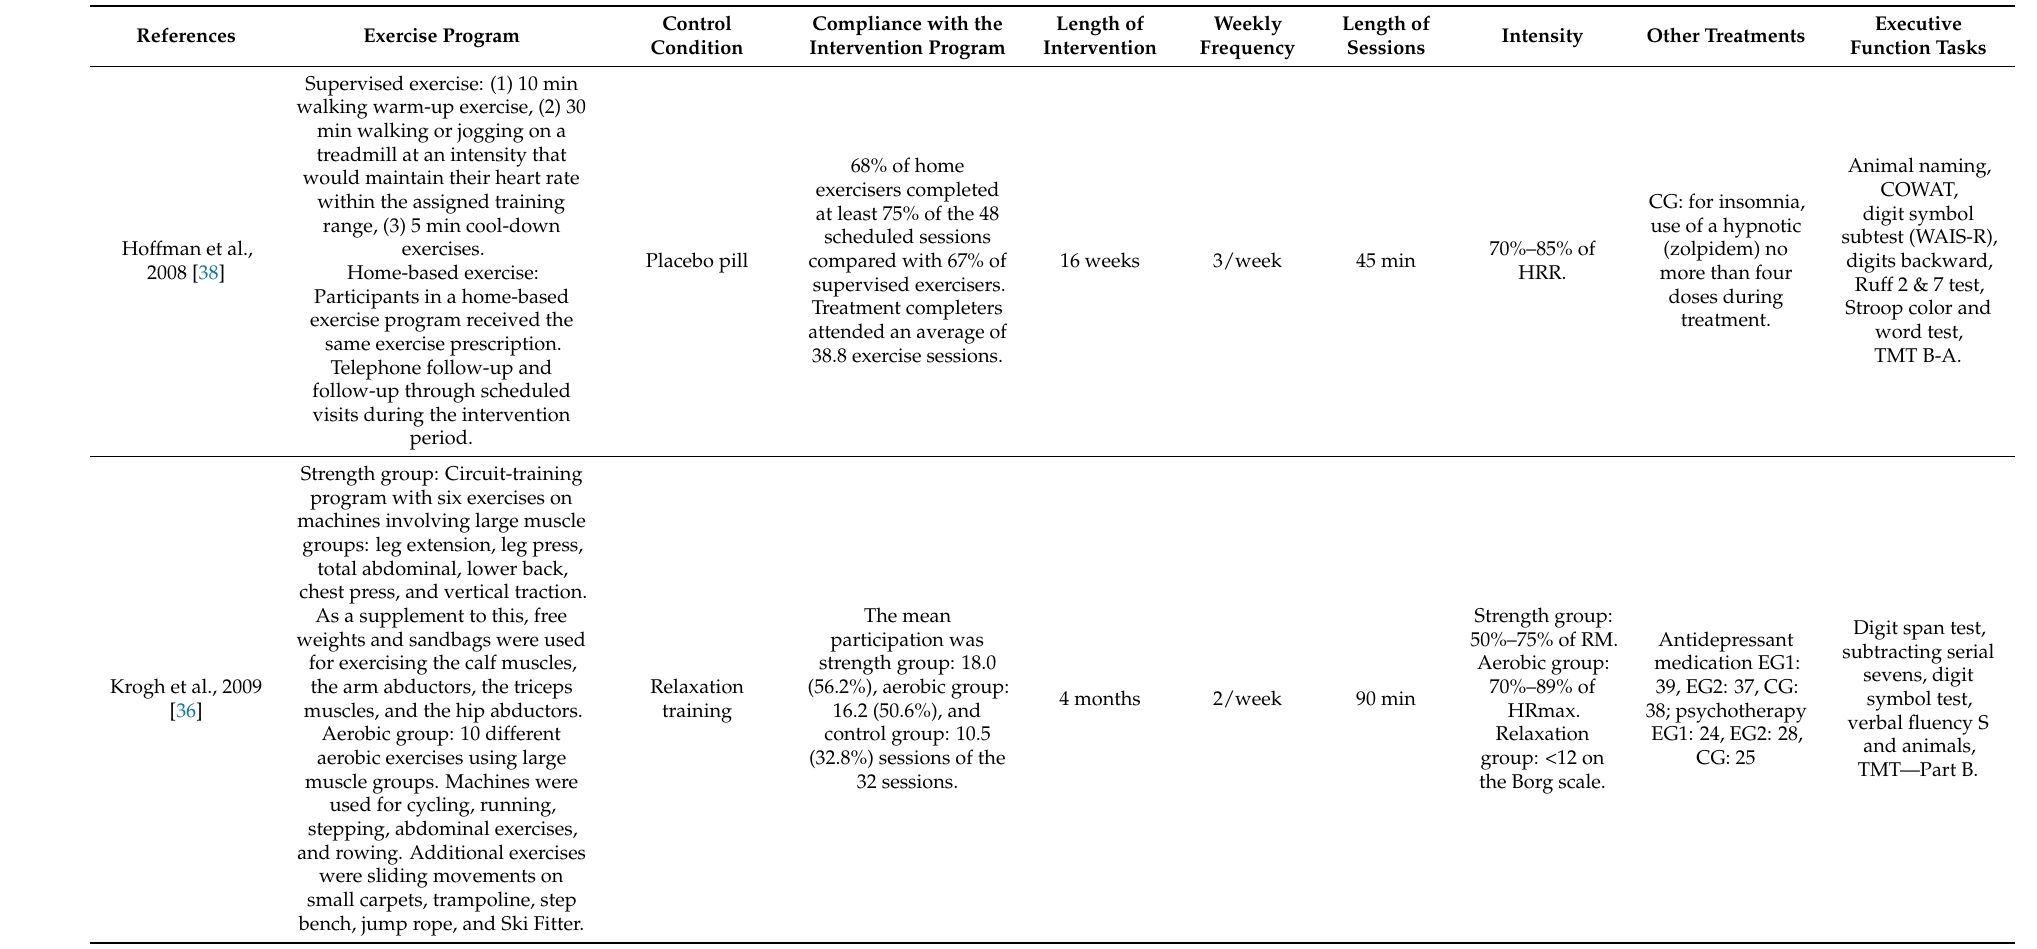
Table 3. Intervention characteristics of the studies